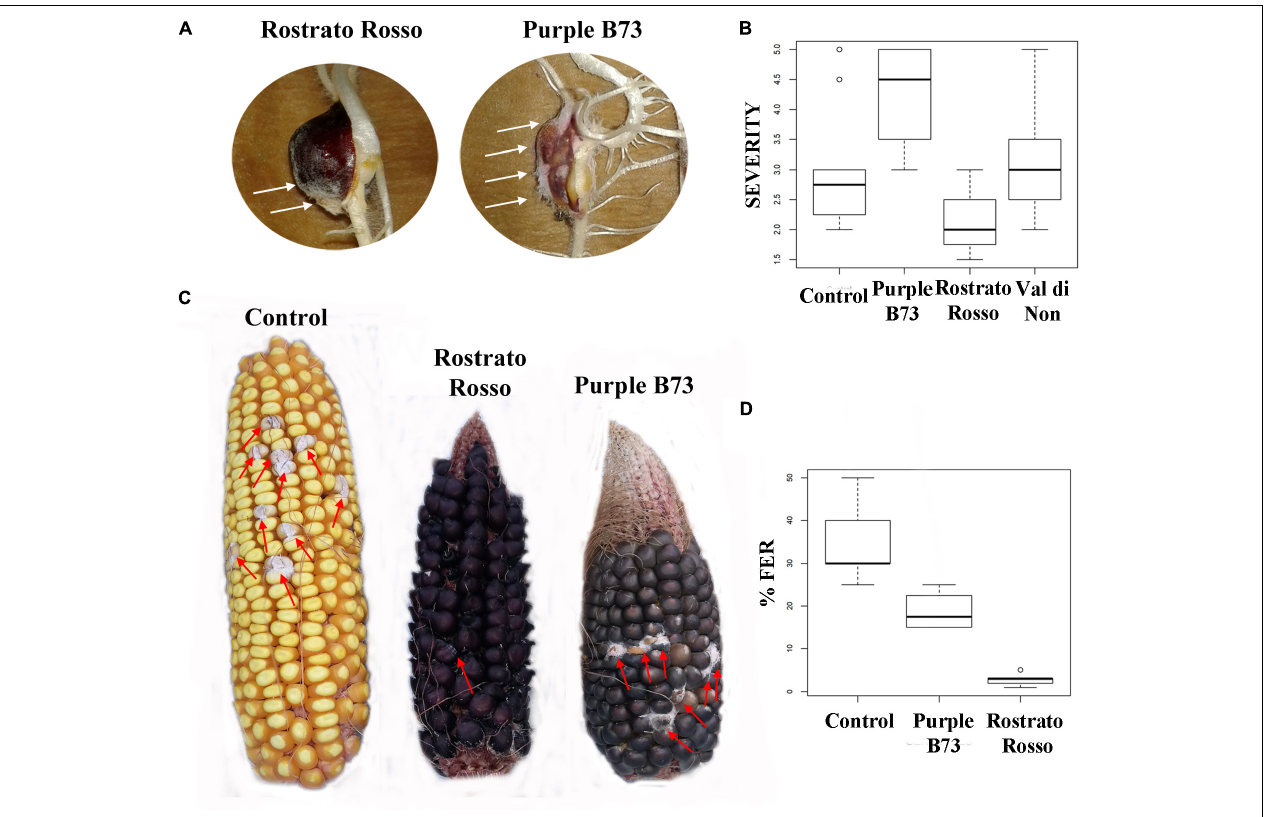
FIGURE 5 | Pictures and box-plots of maize kernels artificially inoculated with F. verticillioides . Examples of treated seedling after RTA assay (A) ; the same genotypes after ear inoculation in field (C) . Box plots representing severity after inoculation in RTA (B) and percentage of FER after field inoculation (D) .